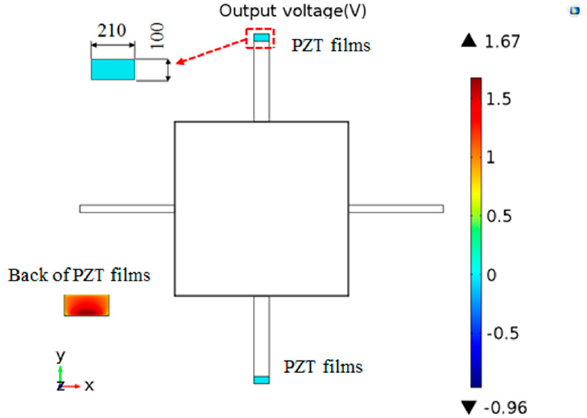
Figure 7. The result of output voltage.